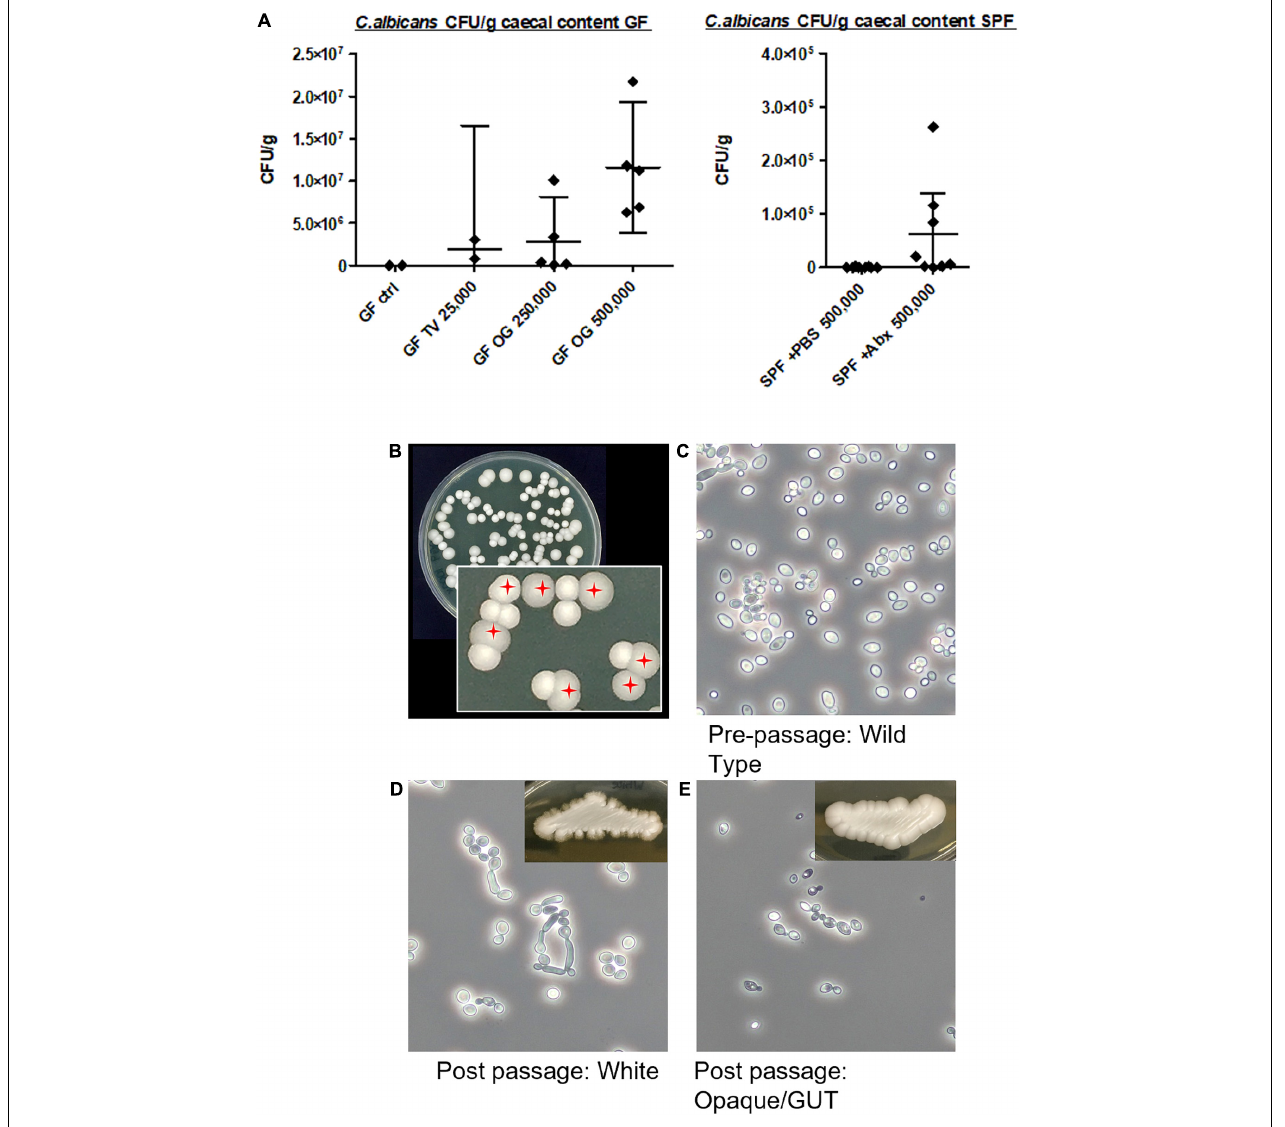
FIGURE 2 | Colonisation of the caecum by Candida albicans NCYC 3115 following tail vein injection or oral gavage. (A) Colony-forming units (CFU) recovered from caecal content following delivery of C. albicans NCYC 3115 to germ-free mice (left) or SPF mice (right). No colonies were present in the caecal content of germ-free control mice administered PBS alone (GF ctrl). TV, tail vein; OG, oral gavage. Numbers on x-axis labels denote amount of C. albicans cells administered, error bars denote 95% CI. (B) Example YM agar plate with zoom inset showing two phenotypically distinct C. albicans colony morphotypes recovered from caecal contents. White and domed morphotype and darker and flattened/Gastrointestinally indUced Transition (GUT) morphotype (red crosshairs). (C–E) Photomicrographs of pre-passage wild type cells (C) , post-passage white phenotype cells (D) , and post-passage darker/GUT phenotype cells (E) , all grown at 37 ◦ C for 3 days in YM